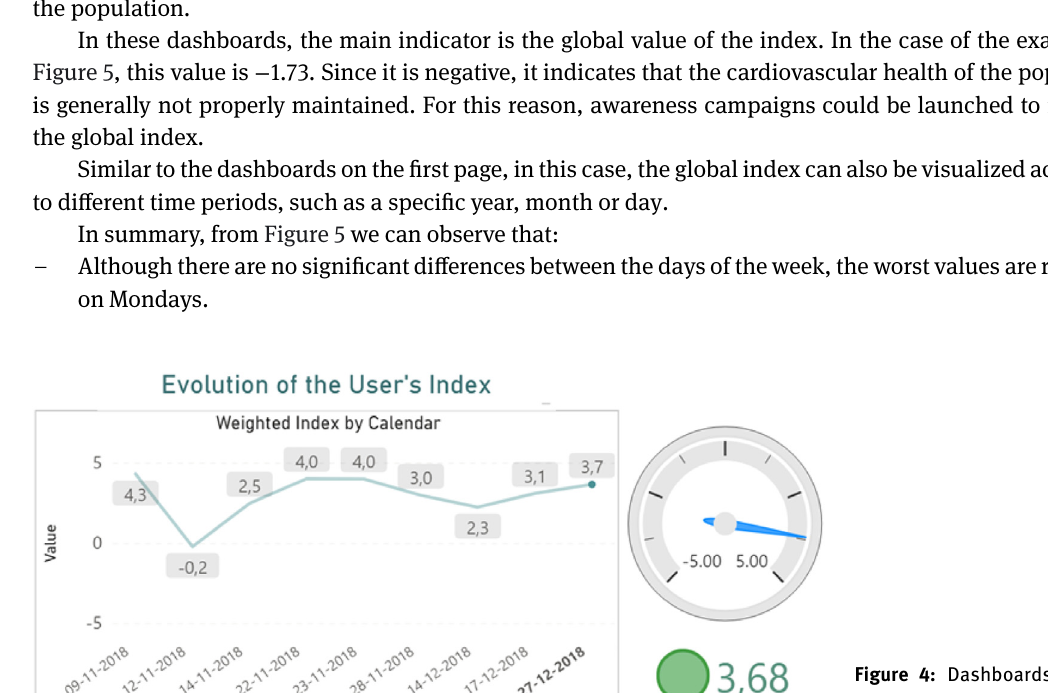
Figure 4: Dashboards to eval- uate the cardiac well-being indexes of a user over